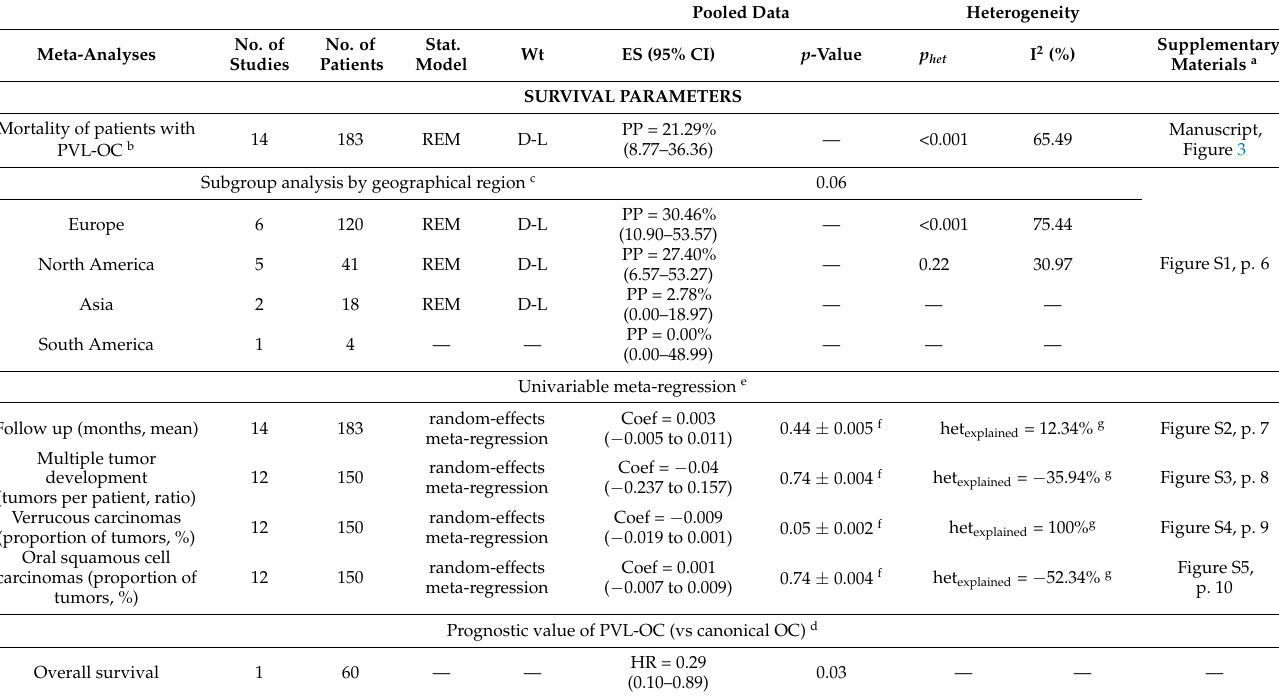
Table 2. Meta-analyses of oral cancer characteristics in patients with proliferative verrucous